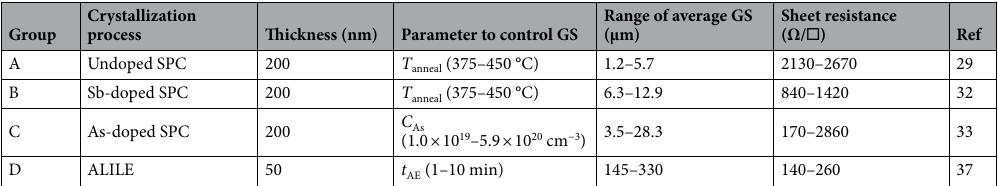
Table 1. Properties of Ge seed